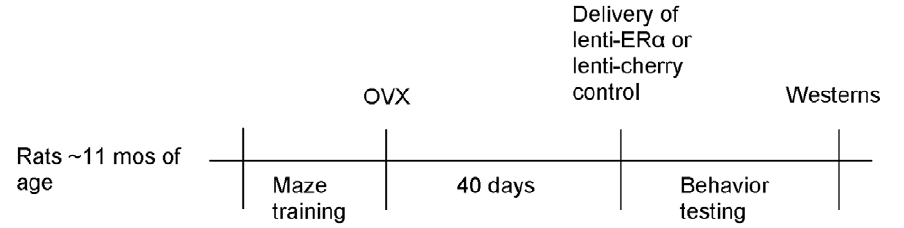
Figure 2. Experimental timeline. OVX=Ovariectomy.